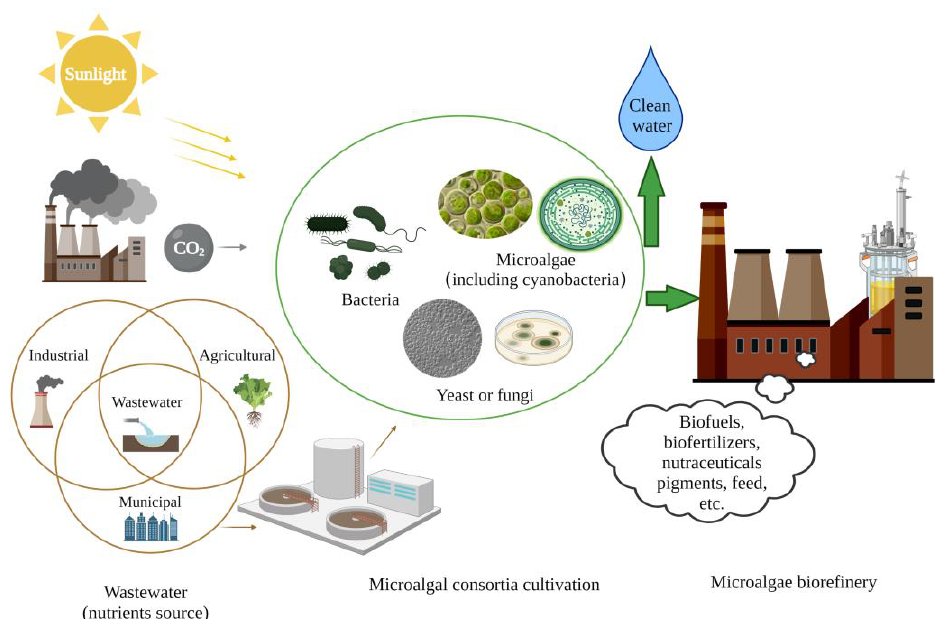
Figure 2. Microalgal consortia in wastewater treatment. Microalgal consortia ( center ) can be used to treat various wastewater ( left ) for clean water and valuable products, such as biofuels, biofertilizers, nutraceuticals, pigments, and feed ( right ).